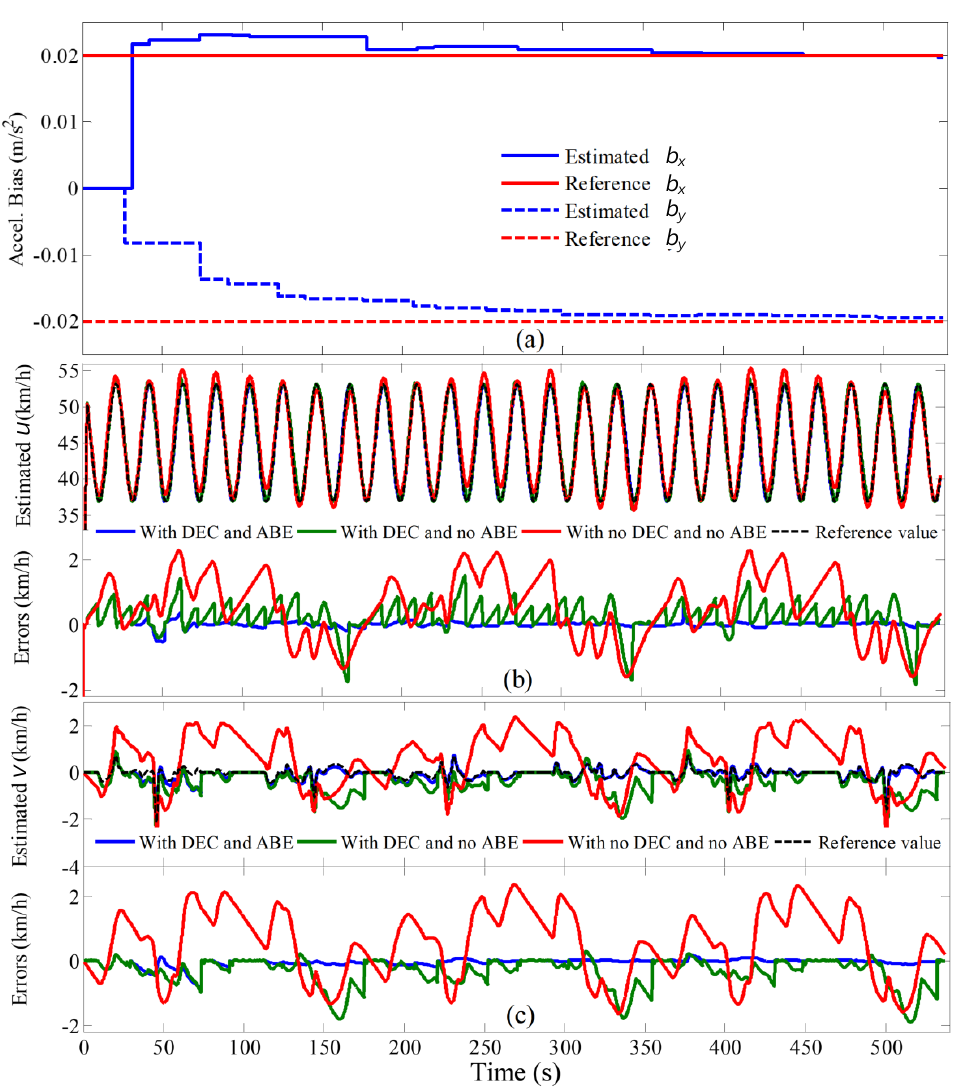
Figure 12. The estimation results during the ring-road test: ( a ) acceleration biases ( b ) longitudinal velocity; ( c ) lateral velocity.